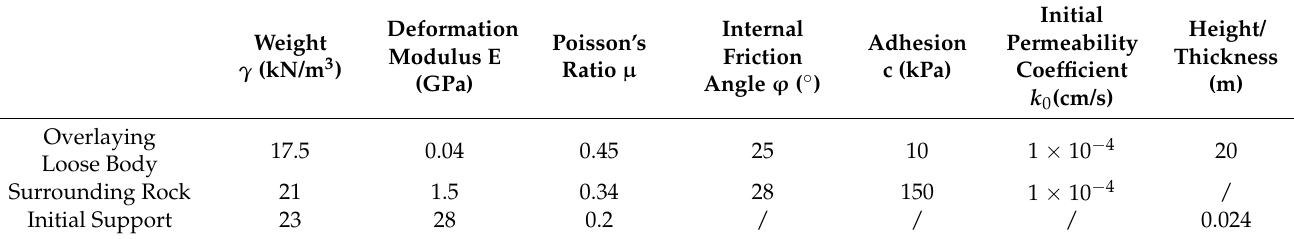
Table 1. Physical and mechanical parameters of materials in simulation.